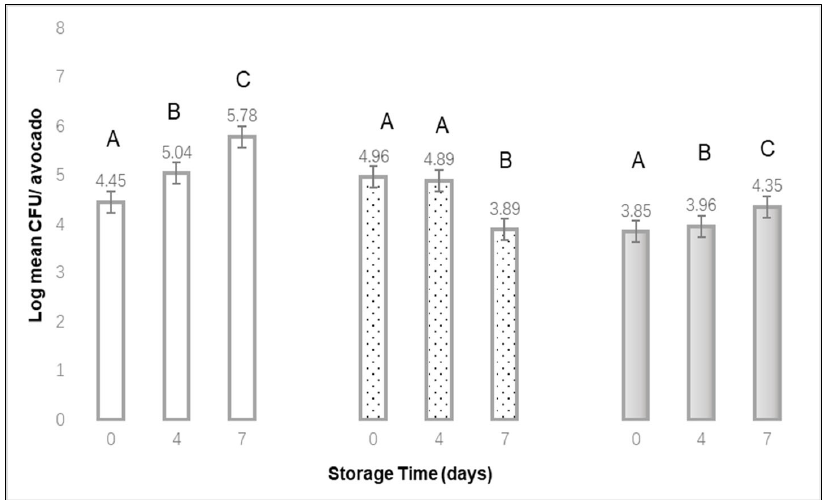
Figure 5. Log Mean CFU per avocado recovered after different storage times, at 10°C, when treated with a 0 min , 2 min , or 10 min , bubble stream (mean of 3 replications × 3 samples). A,B,C Denote significant differences in recovery ( p < 0.01) between storage times for each of the bubble treatment times.